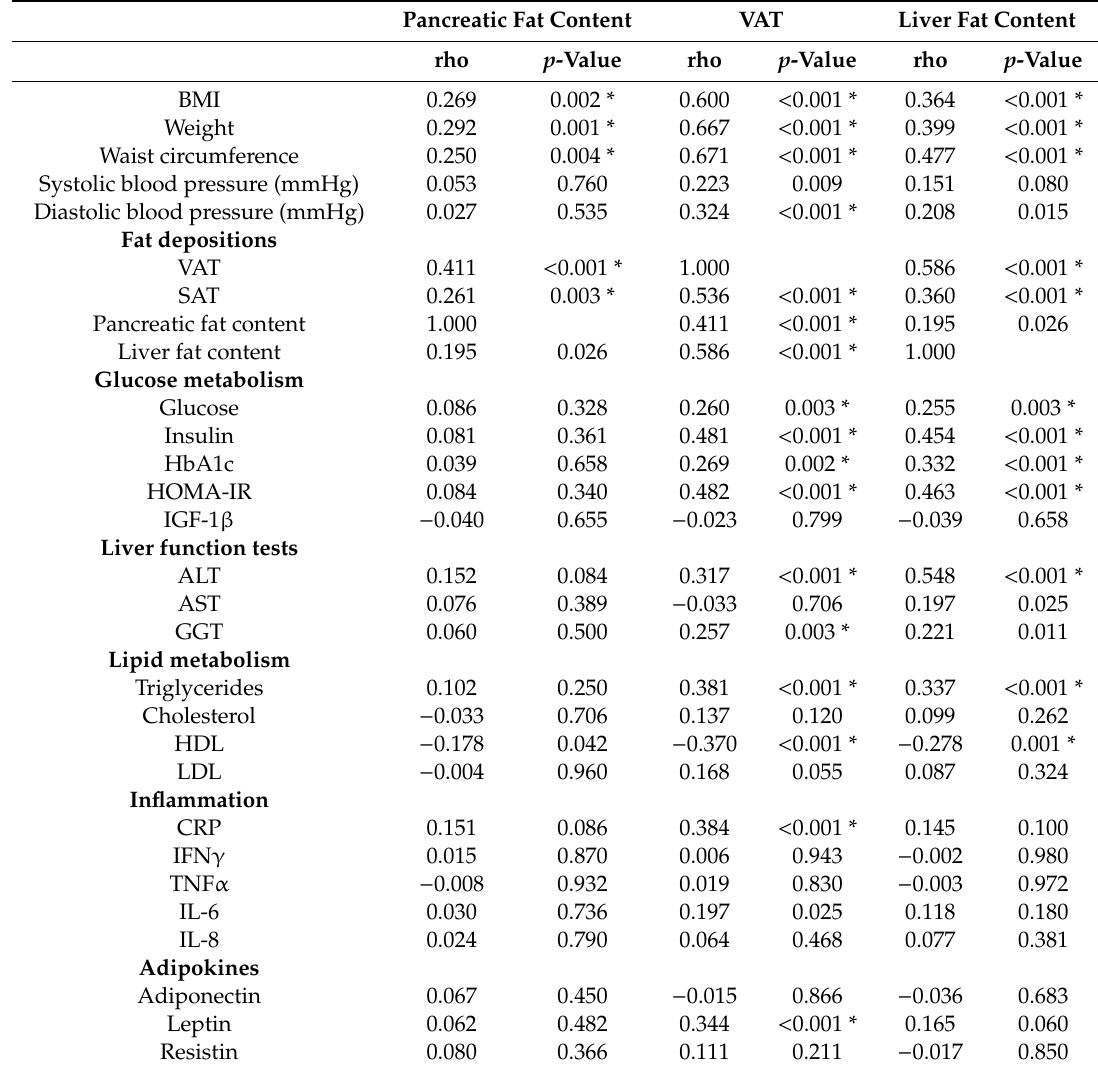
Table 2. Spearman’s correlations between anthropometric parameters, blood pressure, metabolic parameters, and pancreatic fat content, liver fat content, and